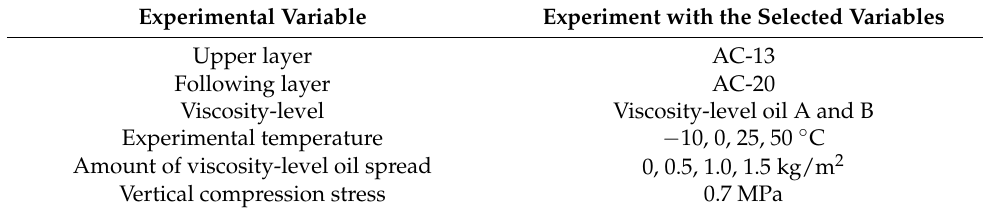
Table 8. Experimental parameters of interlayer interface model.